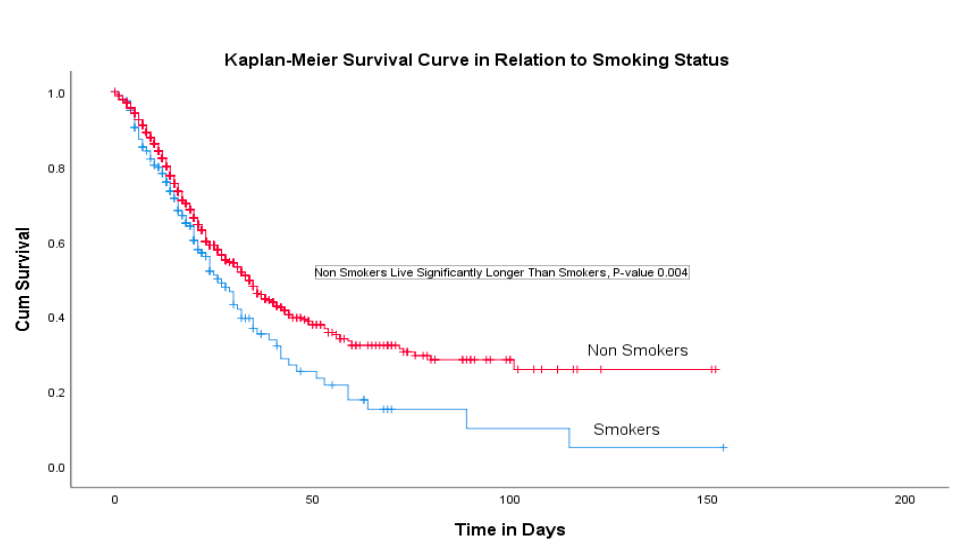
Figure 1. Survival